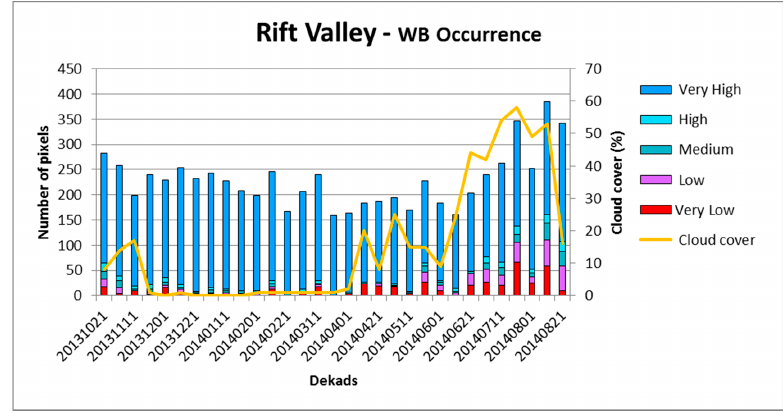
Figure 14. The Water Body Occurrence (WBO) time series for the Rift Valley test area. The “Permanent” larger lakes are not shown in the graph because their large size would overrule the plot.